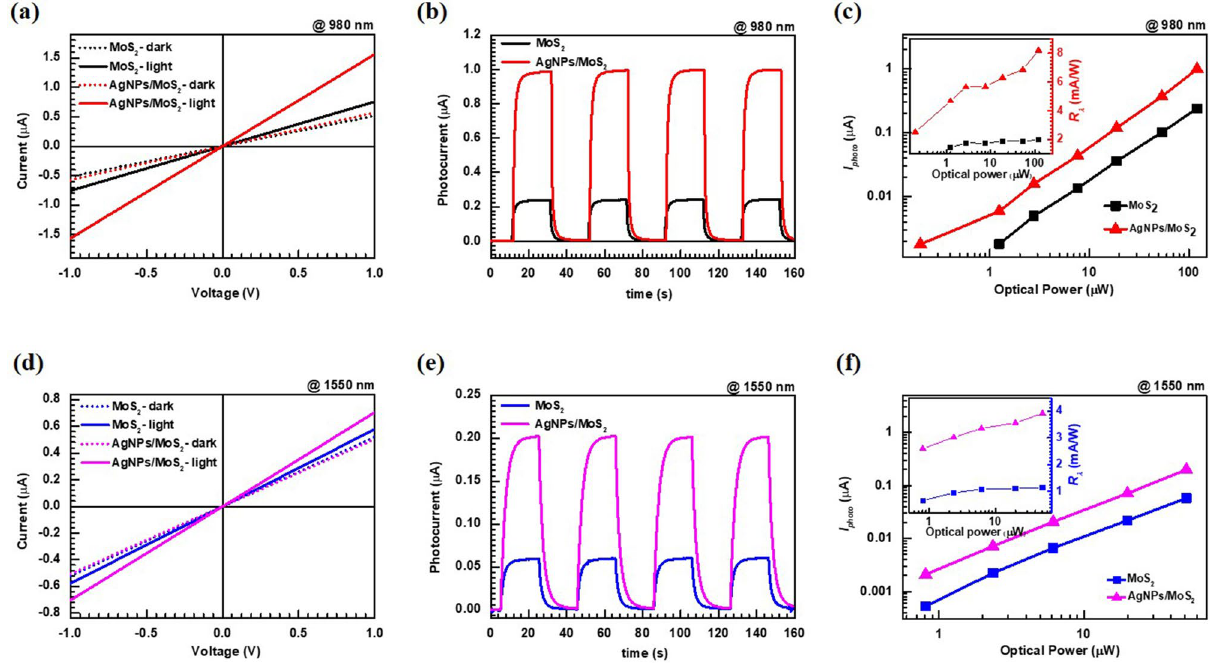
Figure 3. ( a ) I–V characteristics of the MoS 2 photodetectors. ( b ) Transient photocurrent of the photodetectors at V DS = 1 V, and ( c ) photocurrent with respect to illumination power of the devices at the wavelength of 980 nm. The inset shows the responsivity as a function of illumination light power. ( d – f ) The data acquired similarly at the wavelength of 1,550